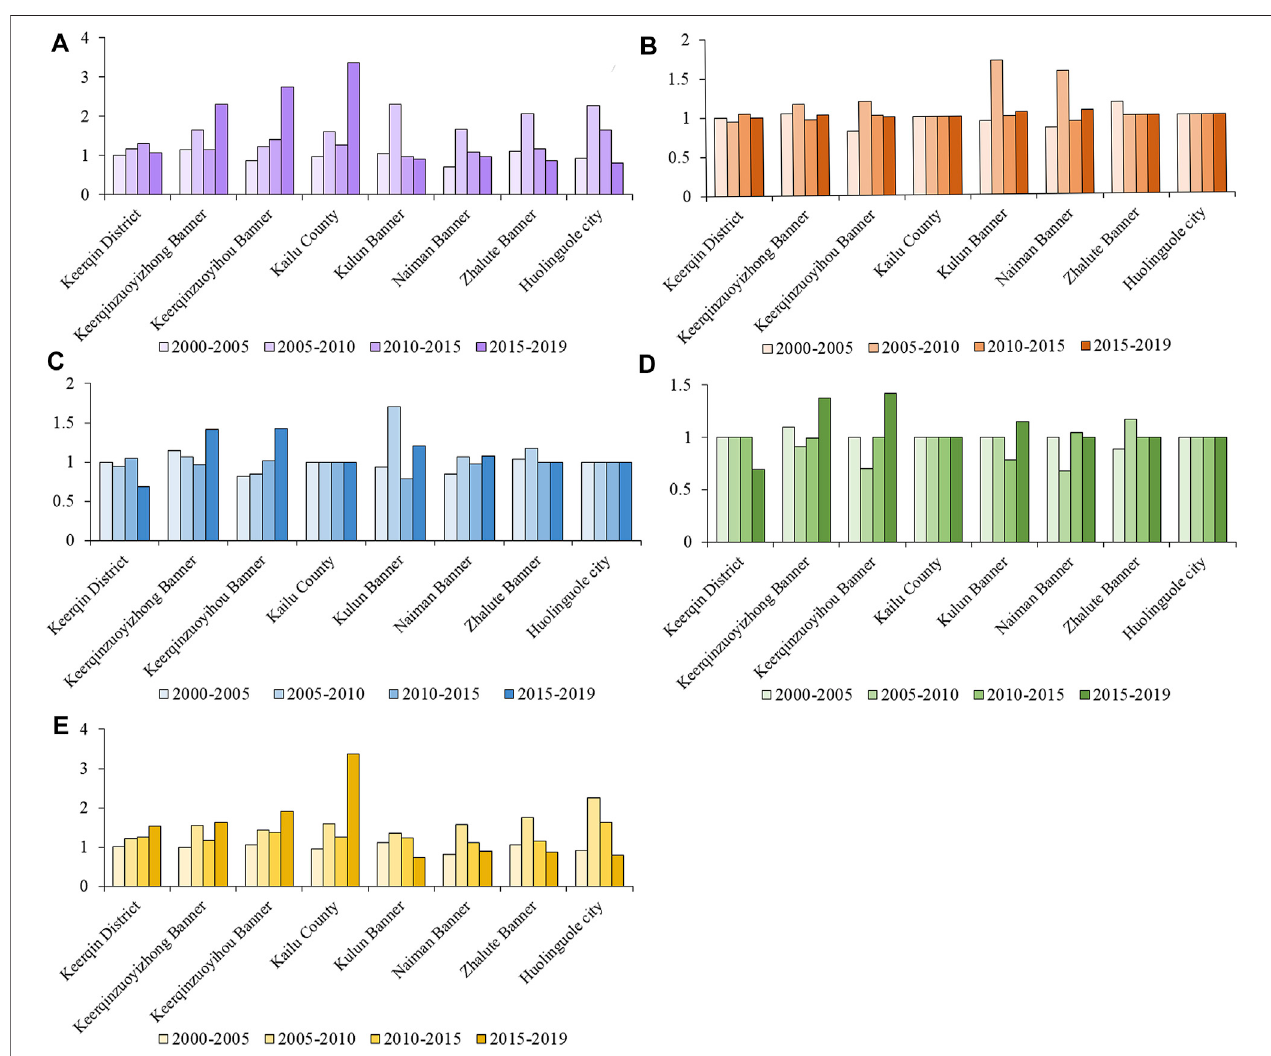
FIGURE2 | Annual Malmquist index and its decomposition of counties inTongliao. (A – E) showed thechangesoftotal factor ecological ef fi ciency, scale ef fi ciency, comprehensive technical ef fi ciency, pure technical ef fi ciency, and technological progress, respectively.